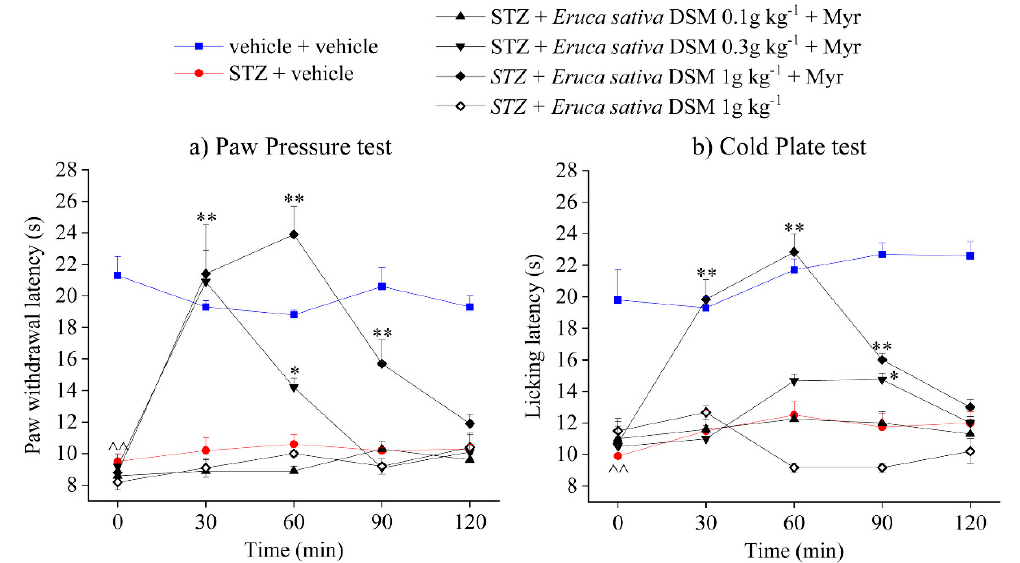
Figure 1. Effect of acute administration of bioactivated Eruca sativa defatted seed meal on streptozotocin (STZ)-induced neuropathic pain. The response to both a mechanical and a thermal stimulus was evaluated by measuring the latency (s) to pain-related behaviors; ( a ) withdrawal or ( b ) licking of the paw. Eruca sativa defatted seed meal (DSM) (0.1–1 g kg − 1 ) was bioactivated by adding 30 µL mL − 1 of myrosinase (Myr) (32 U mL − 1 ) 15 min before the oral administration in STZ-treated animals. Tests were performed 30, 60, 90, and 120 min after the injection. ˆˆ p < 0.01 versus vehicle + vehicle-treated mice; * p < 0.05 and ** p < 0.01 versus STZ + vehicle-treated mice.